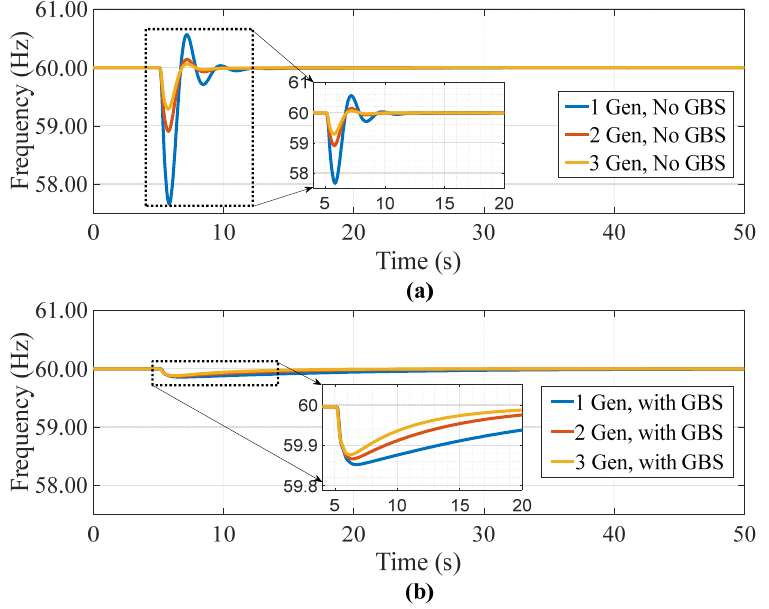
Figure 11. Frequency Dynamics during a Loss of Wind Scenario under Different Number of Gensets. ( a ) Without GBS; ( b ) With GBS using DQ-control scheme.